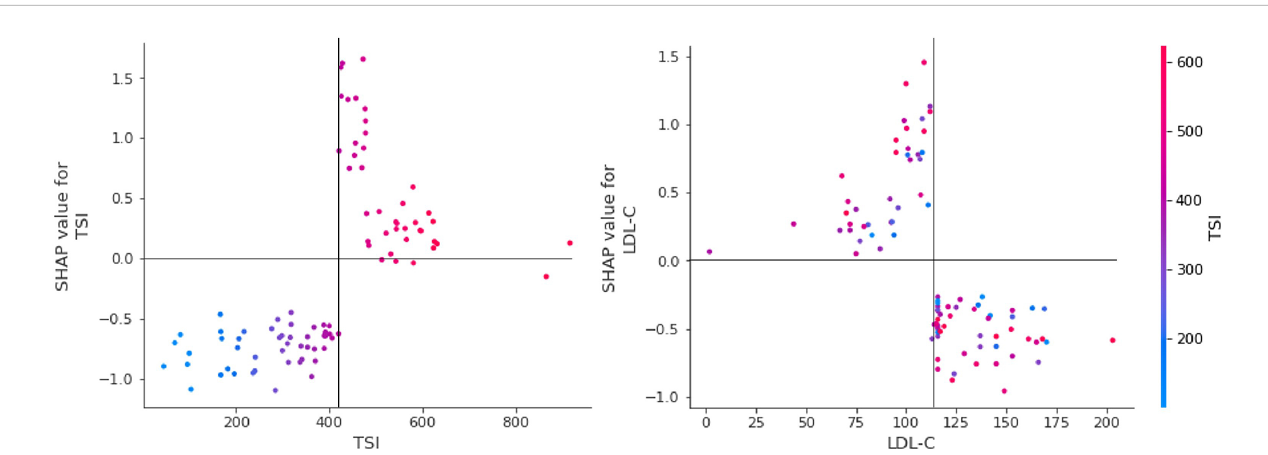
FIGURE 4 SHAP dependence plot for essential features. SHAP dependency analysis of TSI on the left and SHAP dependency analysis of LDL-cholesterol is described on the right. SHAP, SHapley Additive explanation; TSI thyroid-stimulating immunoglobulin; LDL-C low-density lipoprotein